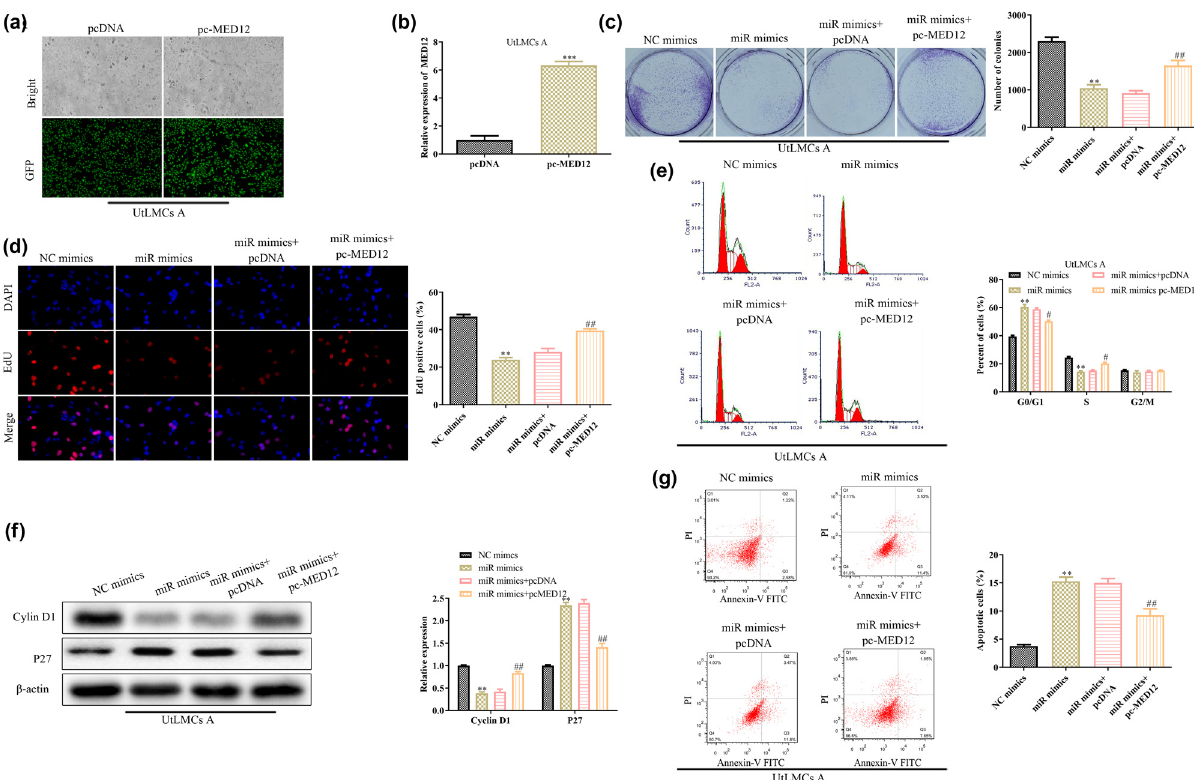
Figure 4: MiR - 199a - 5p inhibits progression of ULM by targeting MED12. Cells were transfected with miR - 199a - 5p mimics, pc - MED12 or their combinations. ( a ) qPCR and ( b ) GFP fl uorescence analyses of the transfection e ffi ciency of pc - MED. Cell proliferation was measured by ( c ) colony formation and ( d ) EdU assays. ( e ) Flow cytometry assay was used to assess the cell cycle. ( f ) The protein expression levels of cyclin D1 and P27 were detected using Western blot assay. ( g ) Flow cytometry assay was used to assess the cell apoptosis. All values are presented as mean ± SD from at least three separate experiments. ** P < 0.01 vs NC mimics group. # P < 0.05, ## P < 0.01 vs miR - 199a - 5p mimics